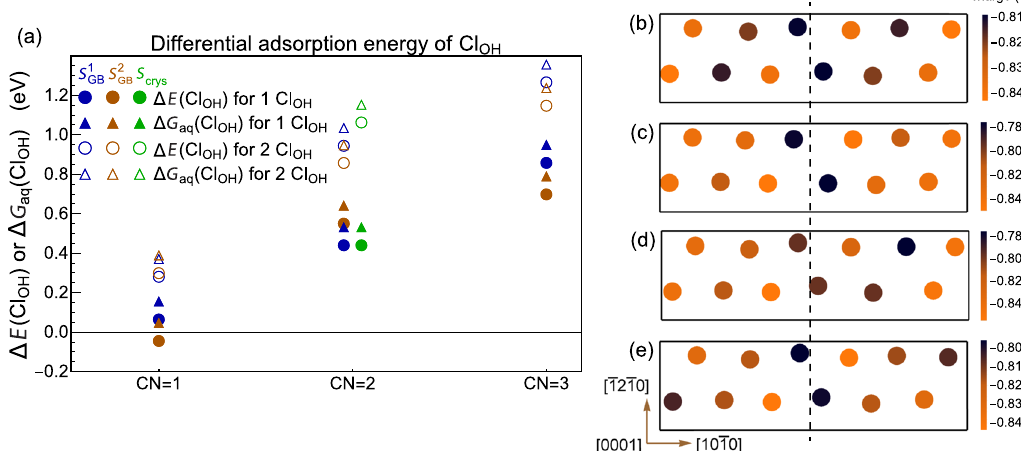
Fig. 6 Cl OH adsorption energies at different surface sites. a Cl OH differential adsorption energies Δ E (Cl OH ) and Δ G aq (Cl OH ) using Eq. (8) and and S 2 surfaces plotted in Fig. 3. Here the coordination number (CN) of adsorbed OH on different Eq. (11) for different OH sites on the S 1 GB GB OH sites can change from 1 to 3. For 2 Cl cases, we report the differential Δ E (Cl OH ) or Δ G aq (Cl OH ) for the second Cl OH adsorption based on the . The circles on O sites represent the Bader charges of con fi guration with the fi rst Cl OH adsorption. b Bader charges calculated for OH on S 1 GB the corresponding OH molecules, with darker colors denoting lower absolute charges. c – e Bader charges for two Cl atoms substitutionally adsorbed on different OH sites (CN = 1, 2, and 3, respectively). where each surface OH is bonded with two neighbor Al atoms (CN = 2) as shown in Fig. 2. This conclusion is true for the cases under both vacuum (Eq. (7)) and aqueous (Eq. (10)) electro- chemical conditions.